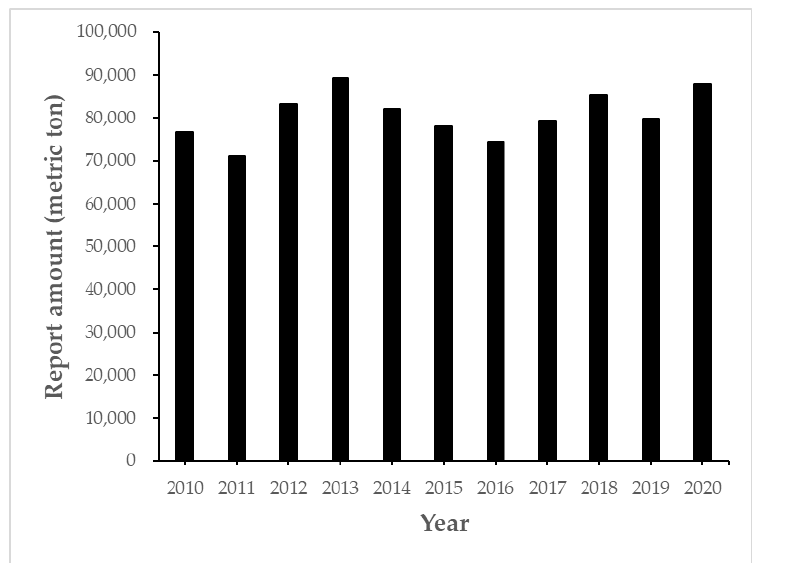
Figure 6. Variation in the reported amounts of waste wood in Taiwan during the period of 2010–2018 [29]. Table 6. Quality standards of solid recovered fuel (SRF) in Taiwan.